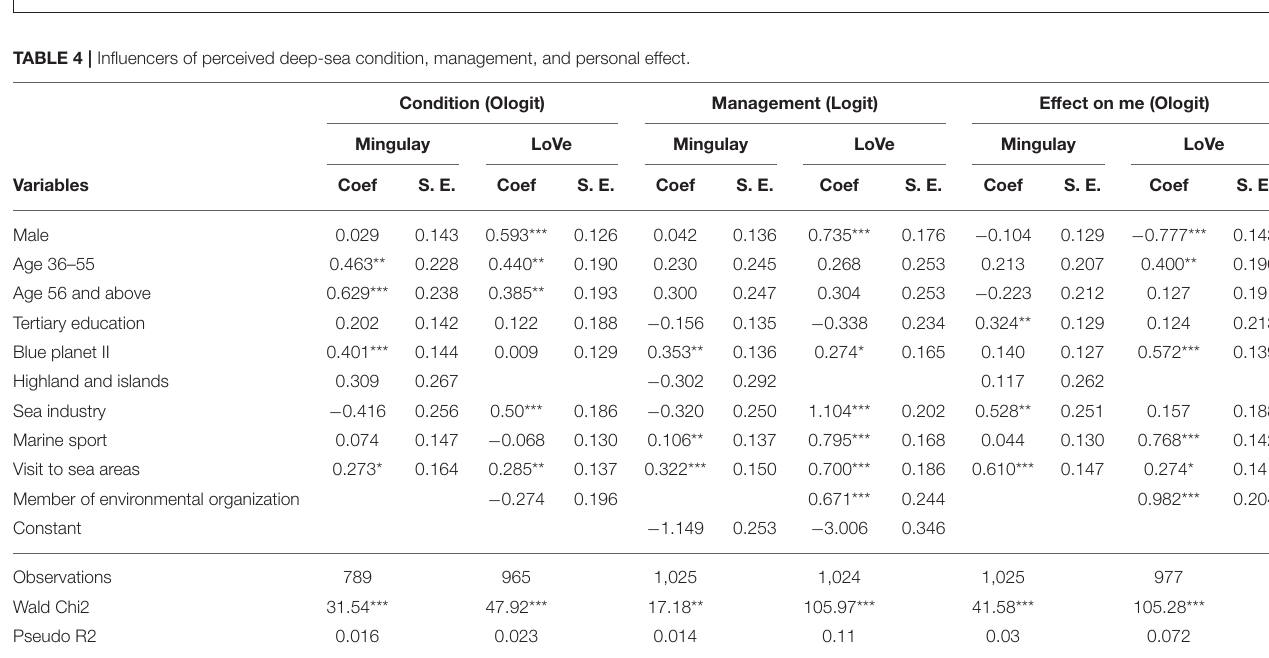
FIGURE 6 | Perception of deep-sea effect on respondent.